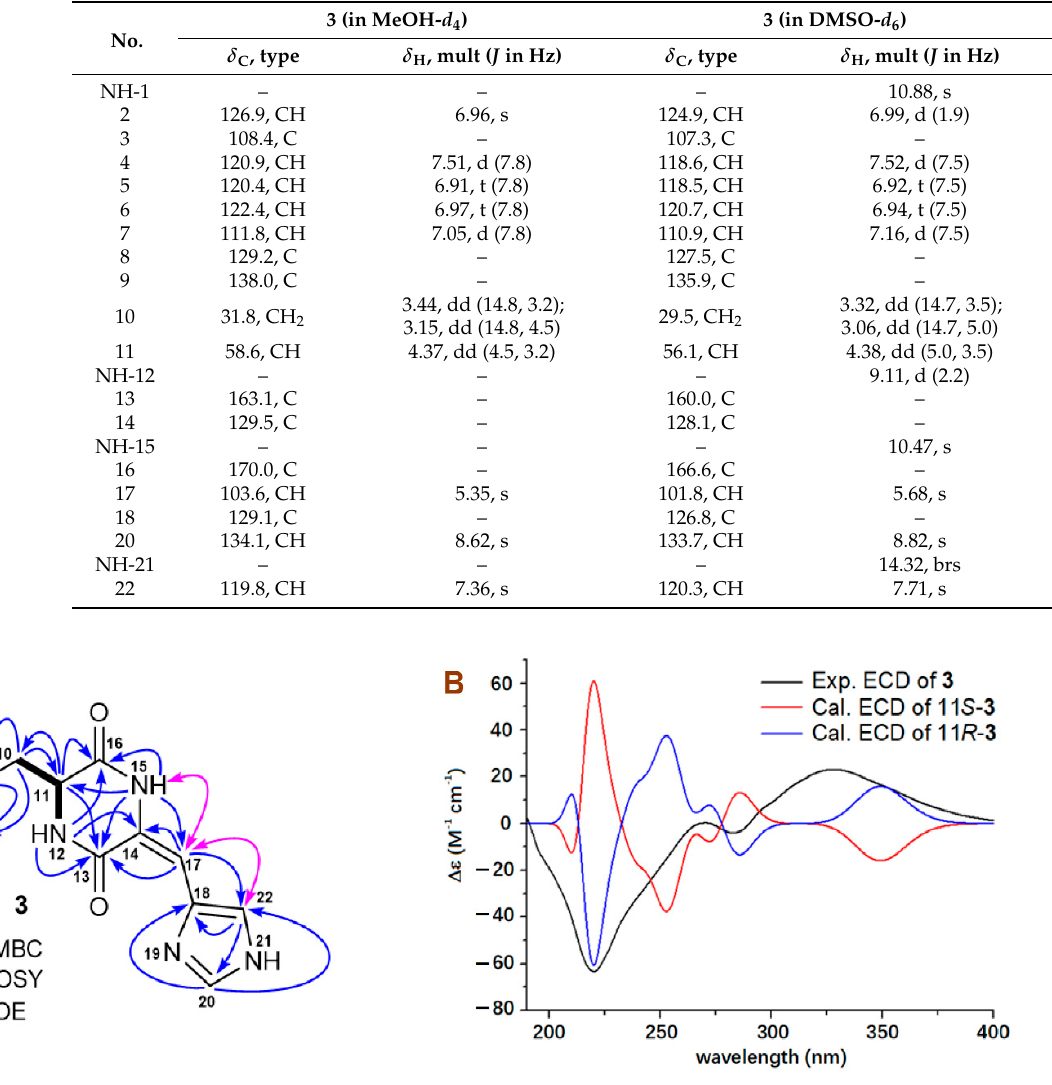
Figure 6. ( A ) COSY, key HMBC, and NOE correlations of 11 R ,14 E -(+)-penilloid A ( 3 ); ( B ) The experimental ECD spectrum of 11 R ,14 E -(+)-penilloid A ( 3 ) in MeOH and the calculated ECD curves of two model molecules (11 S - 3 and 11 R - 3 ) at the b3lyp/6-311+g (d, p) level in MeOH.